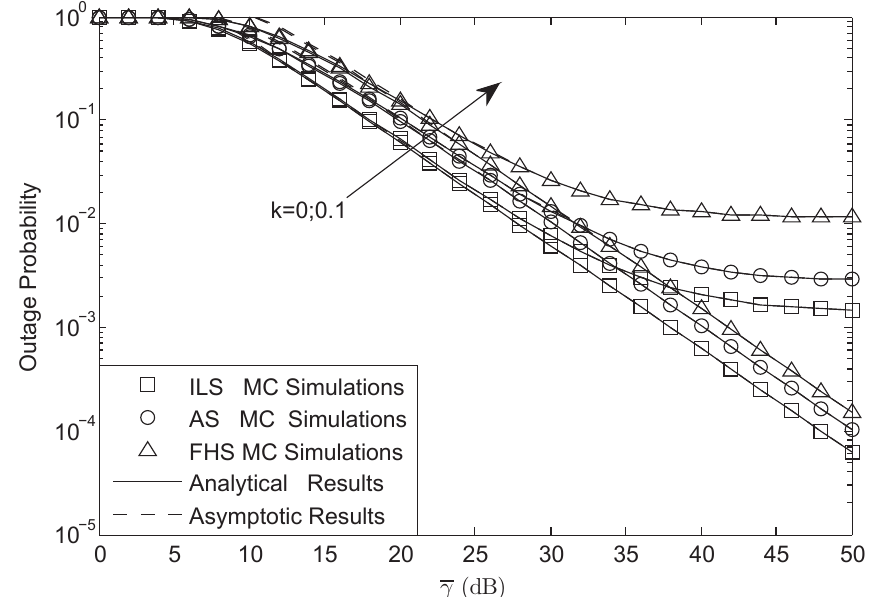
Figure 6. OP of the system versus different γ with M = 3, σ = 0.8, γ 0 = 3 dB and L = 10.